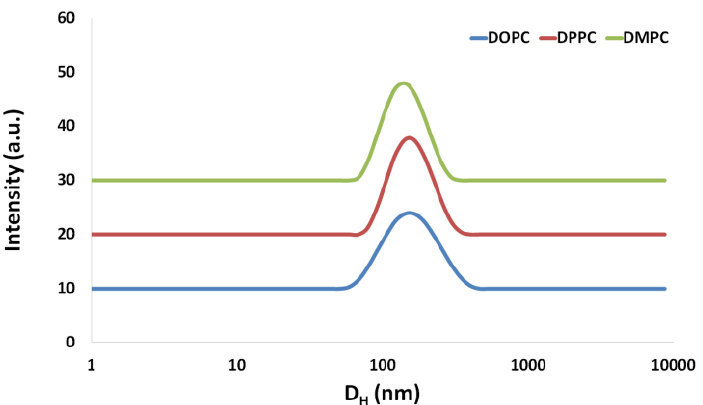
Figure 5. Hydrodynamic diameter (D H ) intensity weighted distribution obtained by DLS on the free liposomes just after the preparation.